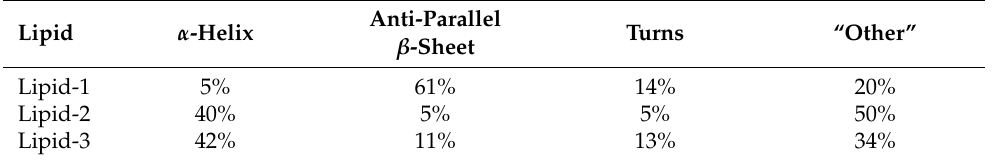
Anti-Parallel Turns “Other” β -Sheet